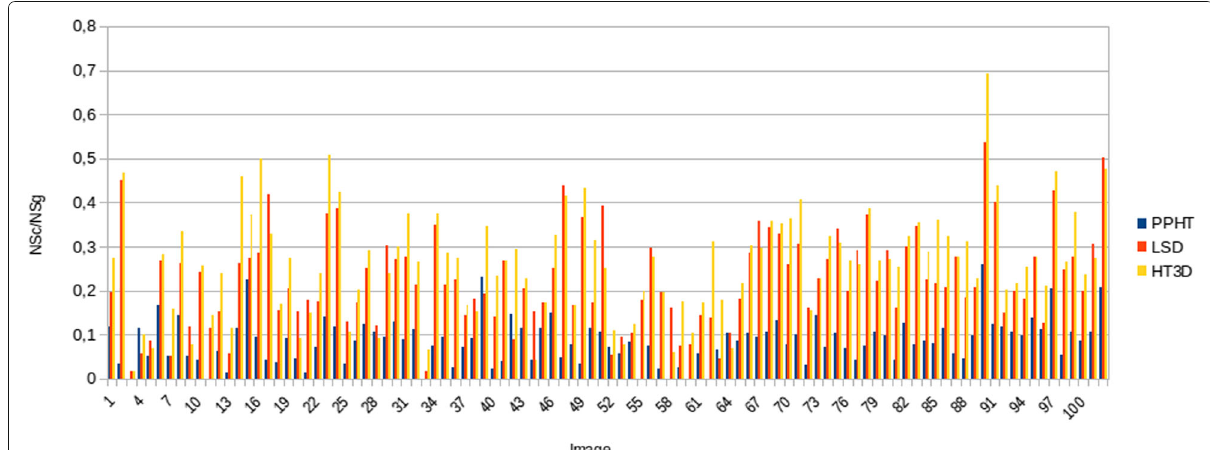
Fig. 25 Ratio between NS c (number of detected segments matching the ground truth data) and NS g (total number of segments of the ground truth data) for the whole dataset considering d S = 3 (distance between ground truth and detected line segments). This ratio measures the hit rates of the three methods for every test image. In general, it is possible to observe a greater correspondence of the results provided by the proposed method with the ground truth data